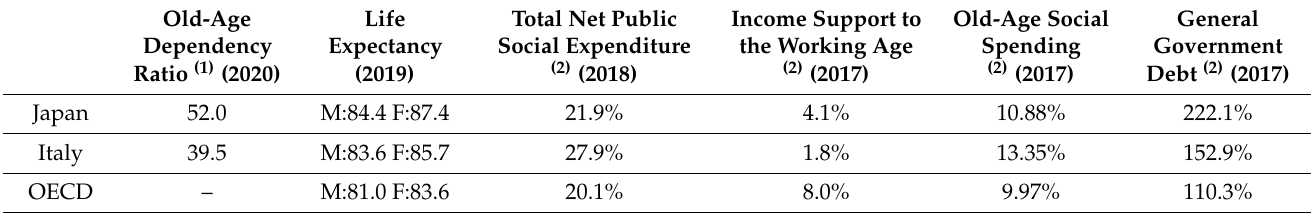
Table 1. Current demographic, economic and welfare conditions in Japan and